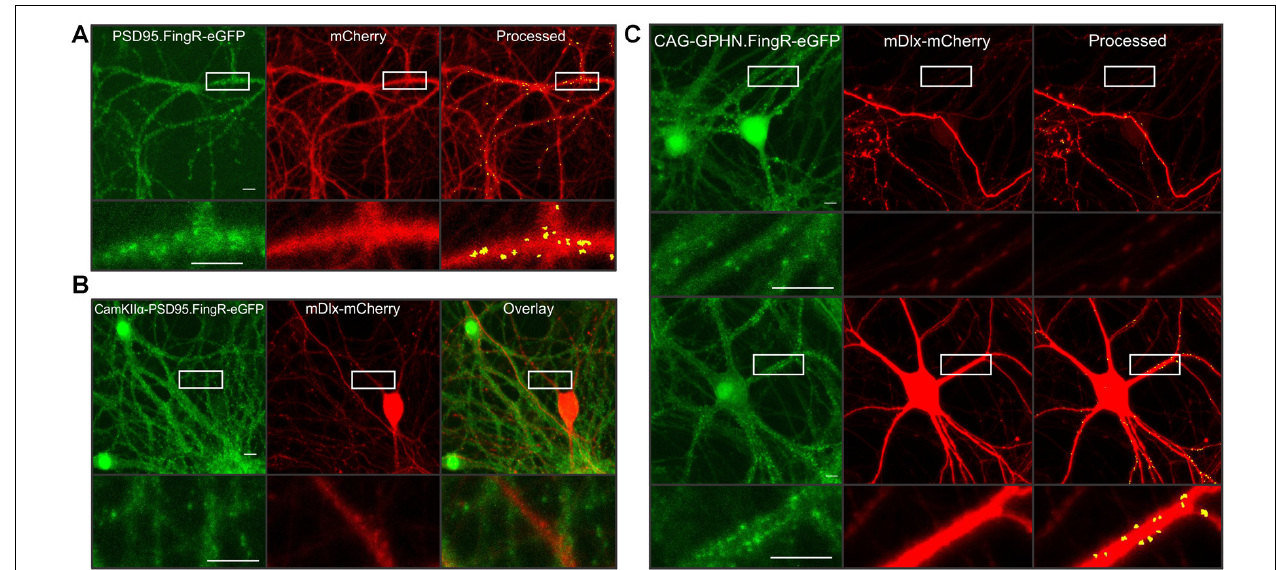
FIGURE 4 | Highlighting the flexibility of automated synaptic imaging assay (ASIA). (A) Sample images show FingR.PSD95-eGFP (green), mCherry (red), and counted puncta (yellow) overlaid on mCherry MIP (processed). Images are representative of > 100 image sets. Scale bar: 10 µ M. ImageJ settings were as follows; Red MIP mask threshold: 0.25 × red MIP mean intensity, Red MIP threshold for particle number: Red MIP mean + 0.25 × SD, Puncta threshold: green MIP mean + 2.5 × SD, puncta size restriction: 4–60 pixels. (B) Sample images show restrictive expression with no overlap between excitatory neurons labeled with CamKII α -FingR.PSD95-eGFP (green) and inhibitory neurons labeled with mDlx-mCherry (red) and overlay. Images are representative of four image sets. Scale bar: 50 µ M. (C) Sample images show two principal neurons (upper panel) and an inhibitory neuron (lower panel) expressing CAG driven GPHN.FingR-eGFP (green). mDlx driven mCherry (red) is excluded from expression in presumed principal neurons (upper panel) but shows high-intensity expression in presumed inhibitory neuron (lower panel). Using identical threshold values, the red mask successfully limits puncta counted to those in the mDlx-mCherry positive neuron (Processed, lower panel) while excluding puncta expressed in the presumed principal neurons (upper panel). Insets display enlarged images of the boxed regions. An mDlx-mCherry positive process that originates from a cell outside of the field traverses the ROI shown in upper panel (red). Images are representative of six image sets. Scale bar: 10 µ M. ImageJ settings were as follows; Red MIP mask threshold: red MIP mean intensity + SD, Red MIP threshold for particle number: Red MIP mean + 0.25 × SD, Puncta threshold: green MIP mean + 2 × SD, puncta size restriction: 4–60